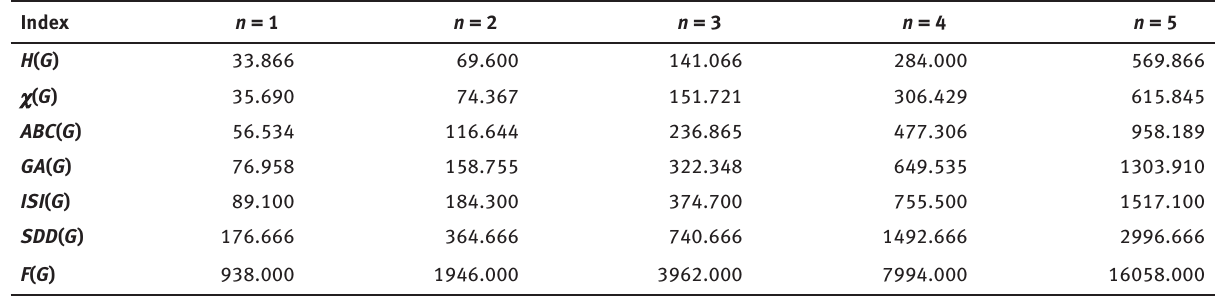
Table 2: Comparison table for degree-based indices